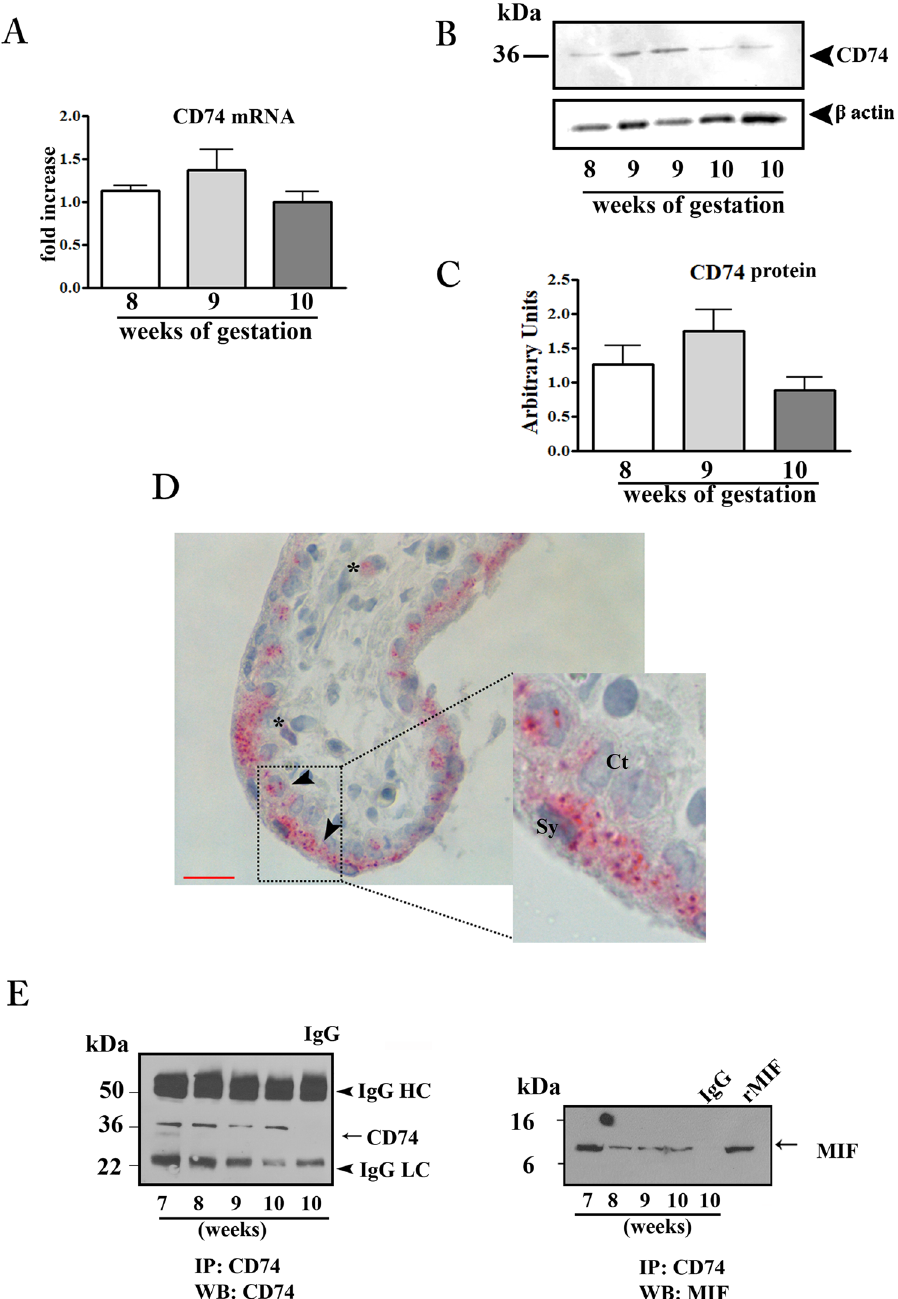
Figure 1. CD74 expression in first trimester placental tissues and interaction with MIF. CD74 mRNA expression assessed by qRT-PCR. ( A ) CD74 mRNA levels were normalized to those of 18S and expressed as fold increase relative to 8 weeks placental tissue selected as calibrator sample. Representative western blot ( B ) and densitometric analysis ( C ) in placental tissues at different weeks of gestation (n = 5 for each week). ( D ) Representative immunohistochemical analysis of CD74 in placenta at 9 weeks of gestation. Slides were counterstained with Mayer’s haematoxylin. Reddish staining represents positive immunoreactivity for CD74. Arrow-head indicates villous trophoblasts; asterisk marks the mesenchymal cells. Ct: cytotrophoblast; Sy: syncytiotrophoblast. Bar = 25 μ m. ( E ) Representative immunoprecipitation (IP) of CD74 in placental tissues from 7 to − 10 weeks of gestation followed by western blot (WB) for CD74 (left panel) and MIF (right panel). IgG: isotype control; rMIF: recombinant